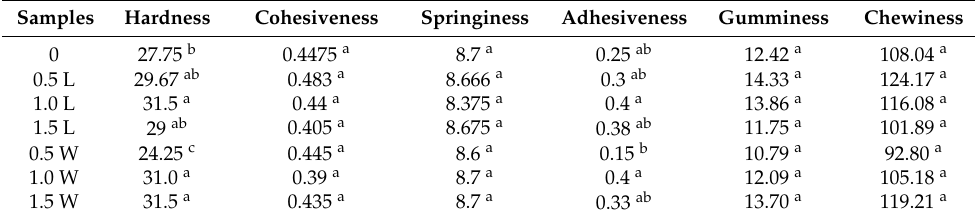
Table 1. Changes in rheological properties of fresh yoghurt (after a night at 4 °C).